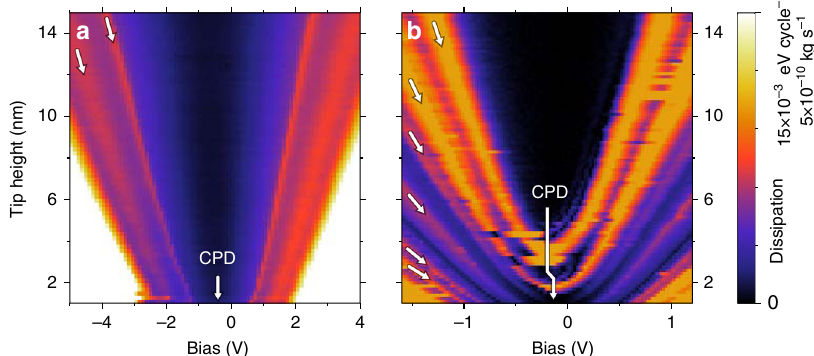
Fig. 4 Local and non-local bias voltage V and tip-sample distance d resolved dissipation maps Γ ( V , d ). The dissipation maps were taken with two different AFM tips suspended in pendulum geometry: a the stiff gold-coated cantilever tip with a moderately low stiffness of 50 N/m driven at a moderate nominal amplitude of 1 nm and b an ultra-sensitive probe with very low stiffness of (0.1 N/m) driven at oscillation amplitudes of up to 5 nm. See also Supplementary Fig. 7 for more details about dissipation